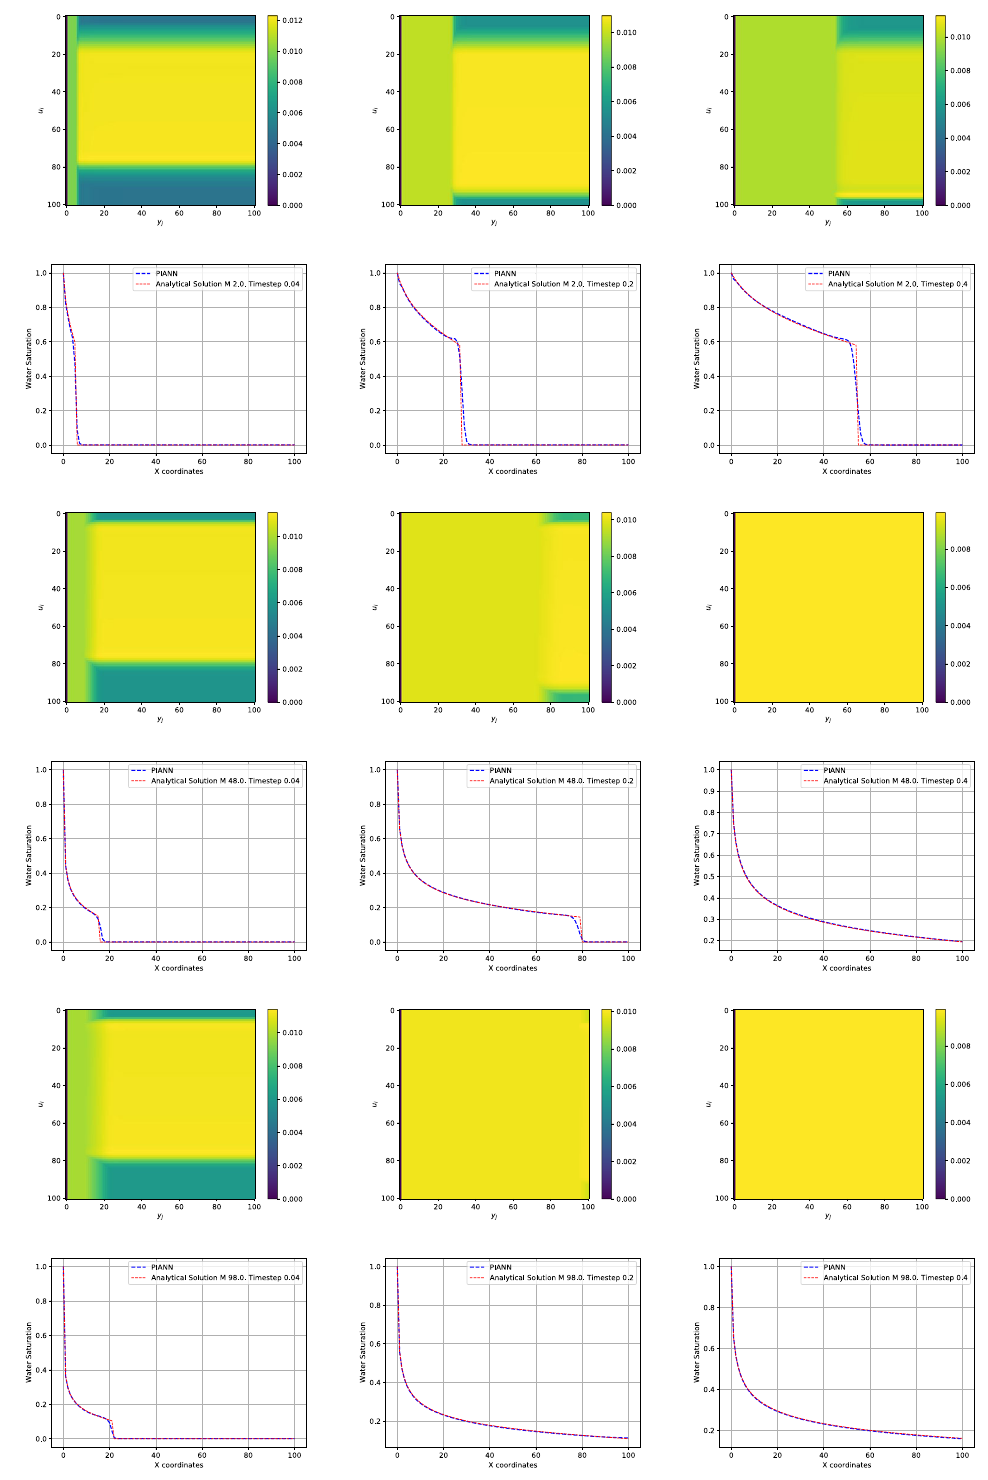
Figure 3. Top and bottom rows correspond to M = 2 and M = 48 and M = 98 for attention weights map and comparison of the predicted by the neural network and the exact solutions of the PDE, respectively. The columns from left to right, correspond to different time steps t = 0.04 , t = 0.20 and t = 0.40